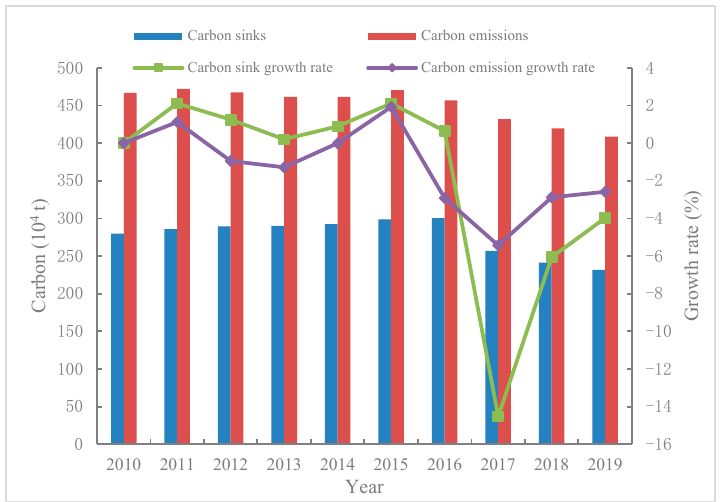
Figure 1. Carbon change in China’s offshore fishing industry from 2010 to 2019.